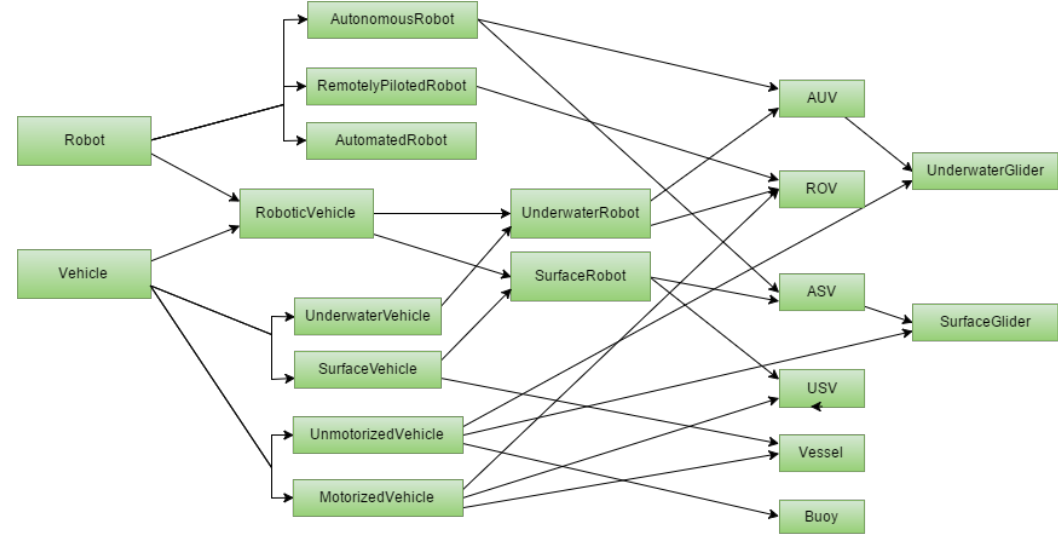
Figure 4. Robotic vehicle taxonomy.